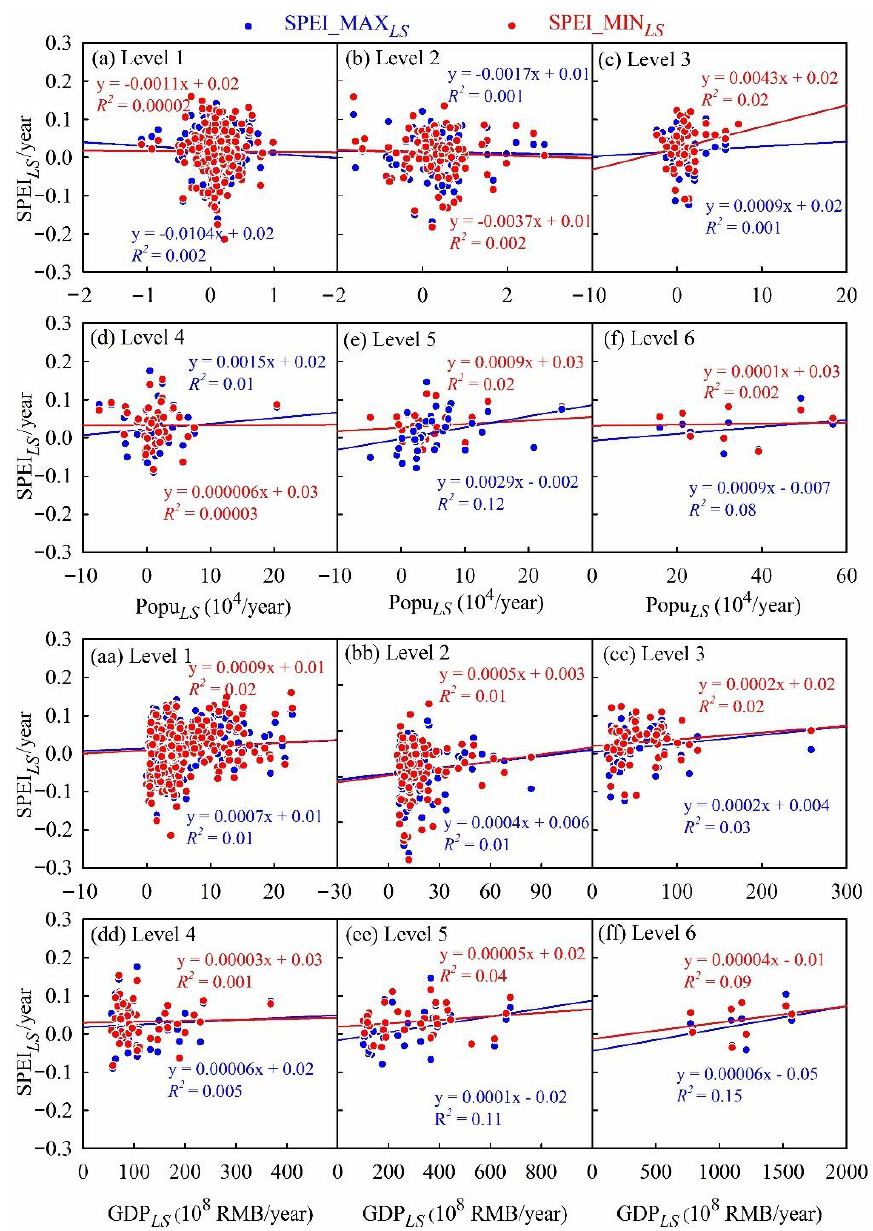
Figure 4. Relationship between pairs of Popu LS , GDP LS and SPEI_MAX LS , SPEI_MIN LS for the different SDLs. ( a – f ) shows relationship between pairs of Popu L and SPEI_MAX LS and SPEI_MIN LS from SDL of 1 to 6. ( aa – ff ) shows relationship between pairs of GDP LS and SPEI_MAX LS and SPEI_MIN LS from SDL of 1 to